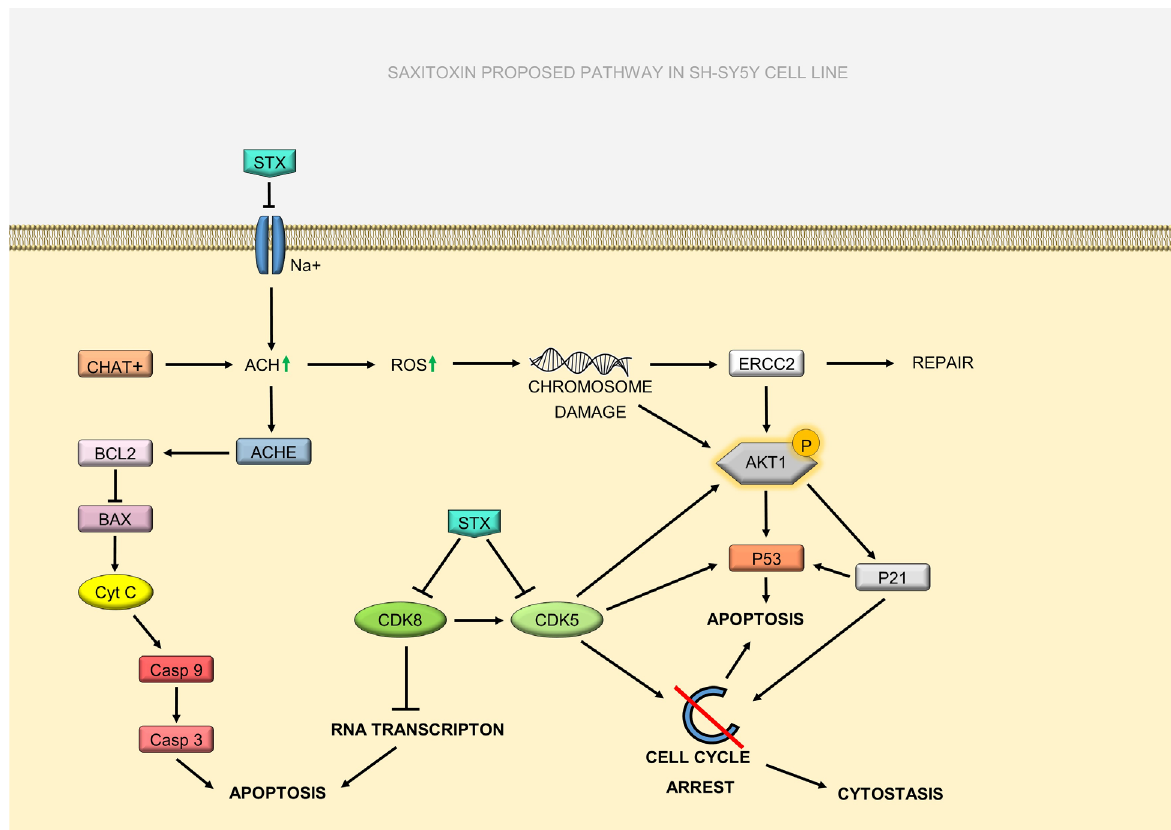
Figure 4. Mechanism of action of STX in SH-SY5Y cell line. STX acts by directly blocking Na + channels as well as inhibiting cyclin-dependent kinases 5 and 8 (CDK5 and CDK8). The overexpression of CHAT, the protein responsible for the synthesis of ACH, and the blockade of NA + channels result in the accumulation of cytosolic ACH. Difficulty in degradation leads to activation of apoptosis via activation of the caspase cascade. The accumulation of ACH leads to the generation of ROS, which induce chromosomal mutations and genomic instability, triggering the apoptotic pathway by TP53 and/or cell cycle arrest (cytostatic effect) by